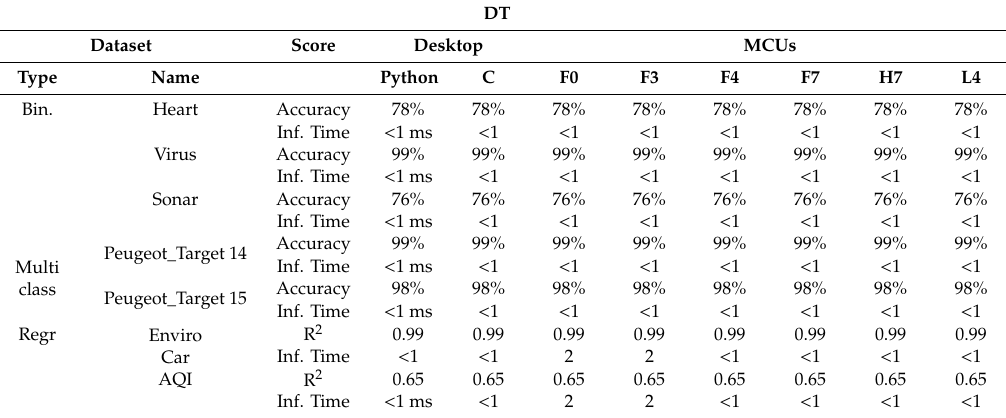
Table 12. Desktop (DT) performance.